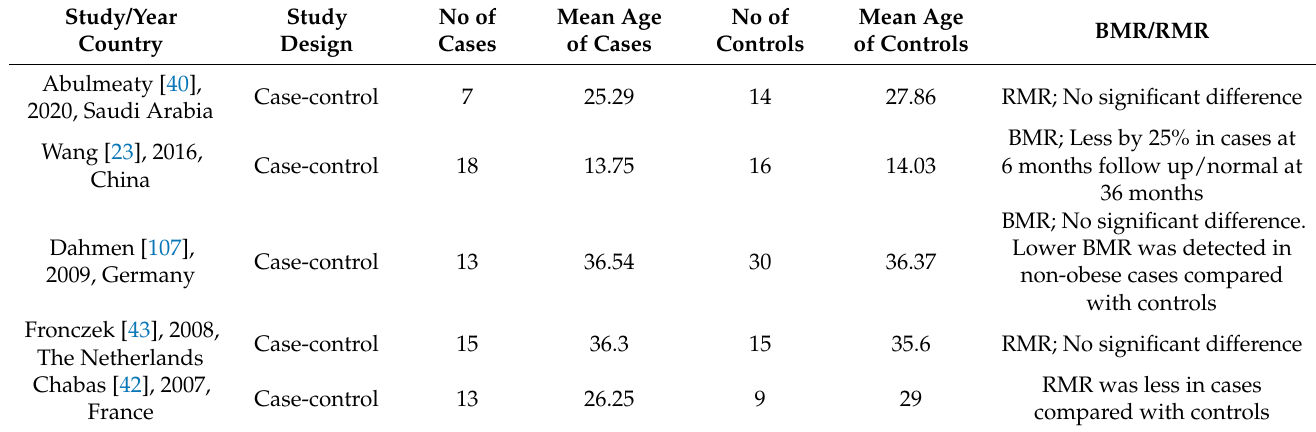
Table 2. A summary of the studies that compared metabolic rates in patients with narcolepsy and